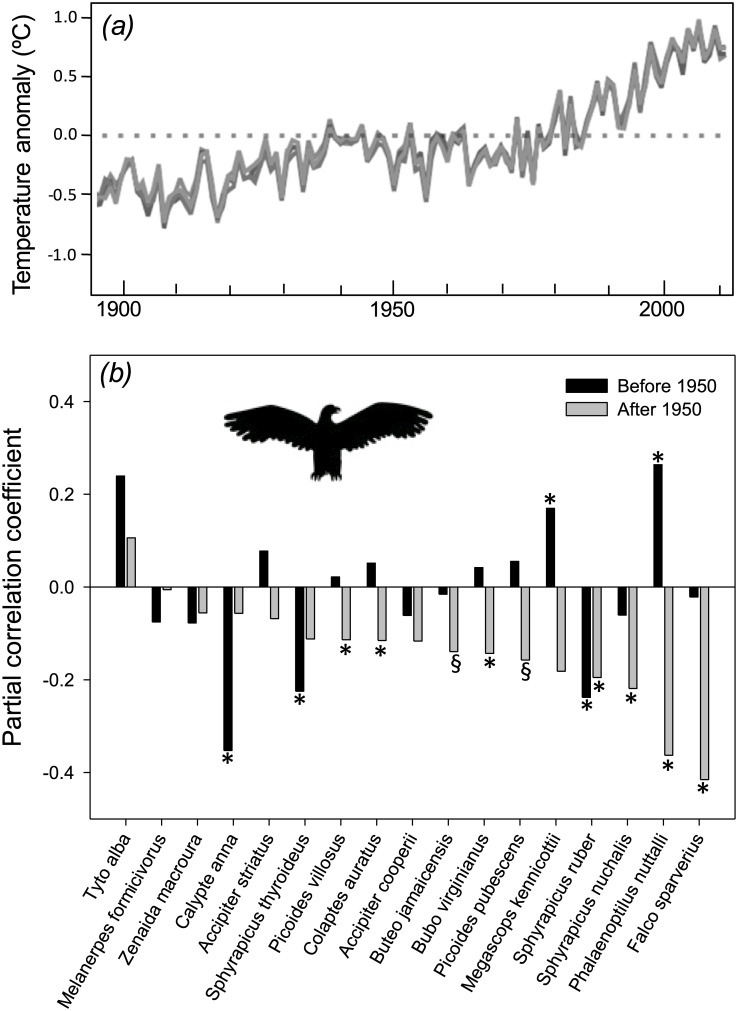
(a) Change in land surface temperature for the last century (modified from [29]), and (b) correlation coefficient between body size and year of collection for terrestrial bird species during the first (before 1950) and second (after 1950) half of the 20th century.* denotes P < 0.05 and § denotes P < 0.1.